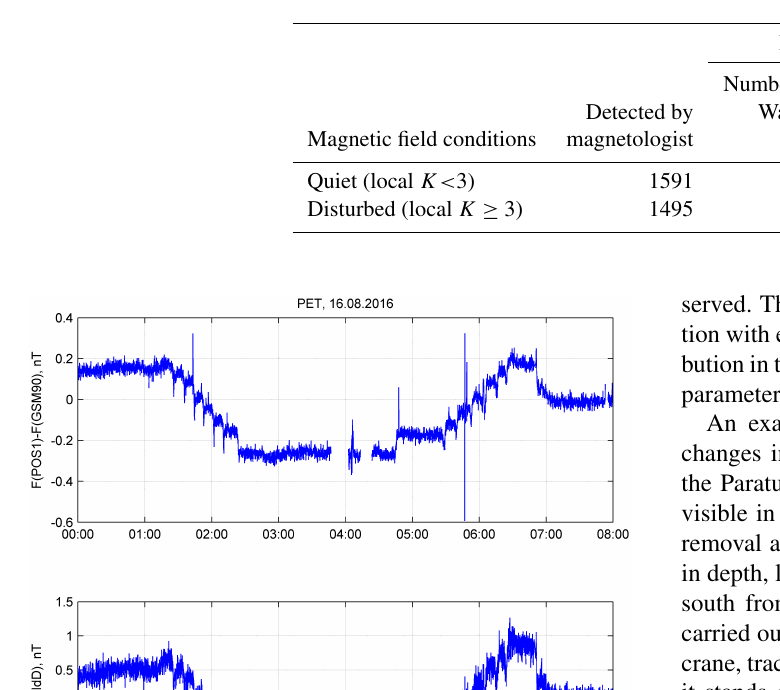
Table 2. The results of the estimation of the algorithm effectiveness for the Hyderabad observatory.